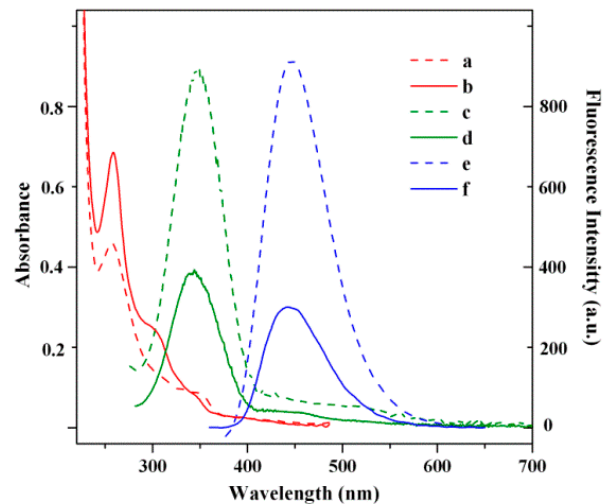
Figure 5. UV–vis (a, b), FL excitation (c, d) and FL emission spectra (e, f) of the FCD solution in the absence (a, c, e) and presence (b, d, f) of 50 μ M Cu 2+ .